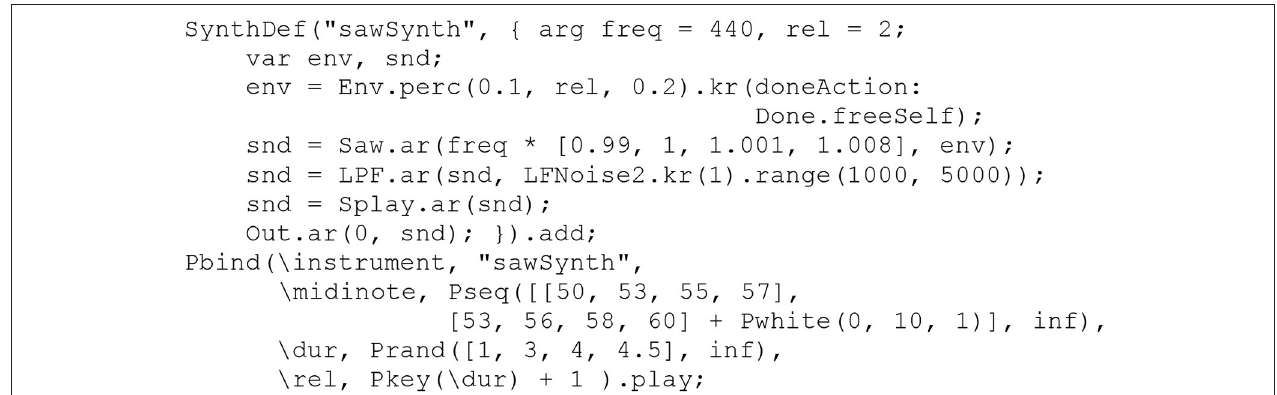
FIGURE 7 | A simple SuperCollider composition and synthesis program, based on examples by Bruno Ruviaro (http://sccode.org/1-54H).